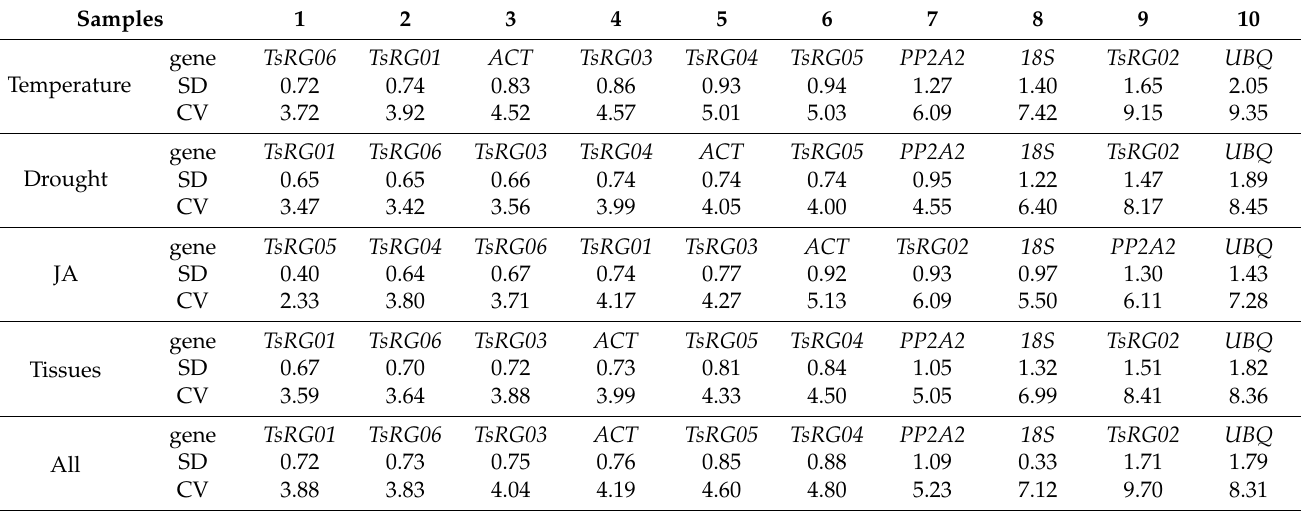
Table 3. Expression stability values of candidate RGs under different conditions were calculated by